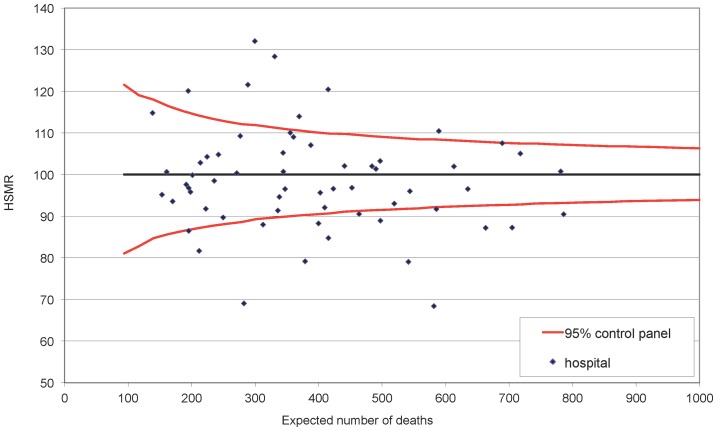
Funnel plot showing the HSMRs of Dutch hospitals in 2009.